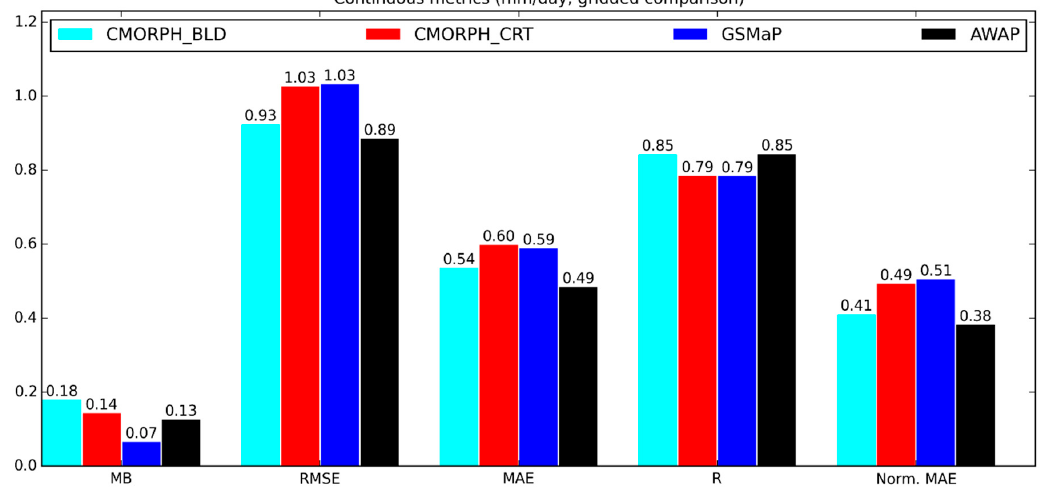
Figure 11. Gridded comparison of satellite datasets and AWAP against ERA5 reanalysis from January 2001 to December 2018. Mean bias (MB), root-mean-square error (RMSE), mean average error (MAE), R and normalised MAE are